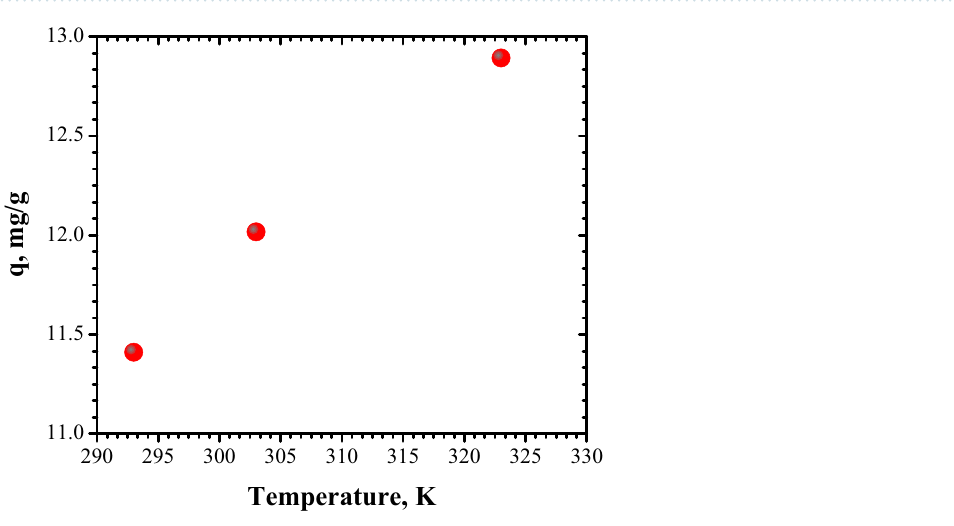
Figure 17. Effect of temperature on adsorption of Congo Red